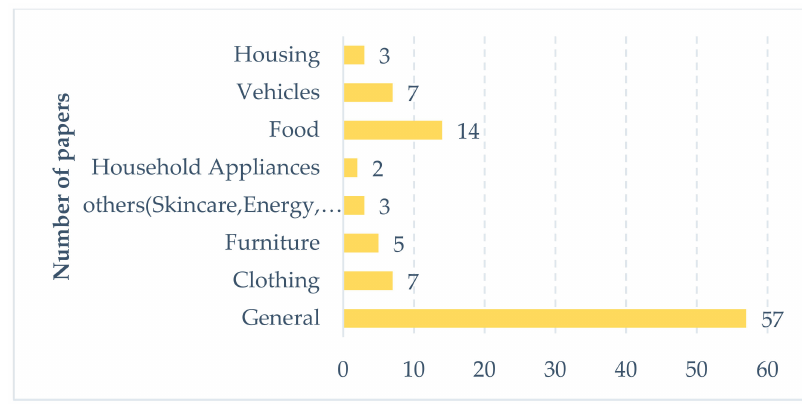
Figure 2. Distribution of papers across product category. Table 1. Classification and summary according to product